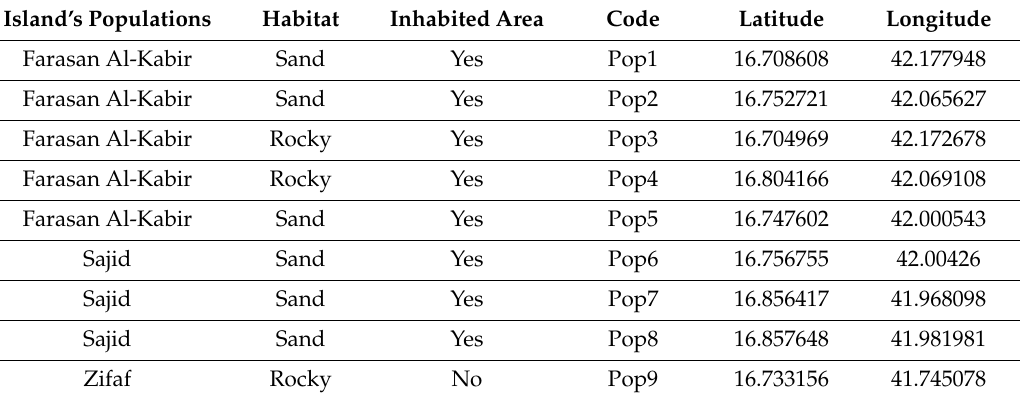
Table 2. A. marina populations tested (name and code), latitude and longitude of the location, island area, island habitat, and inhabited